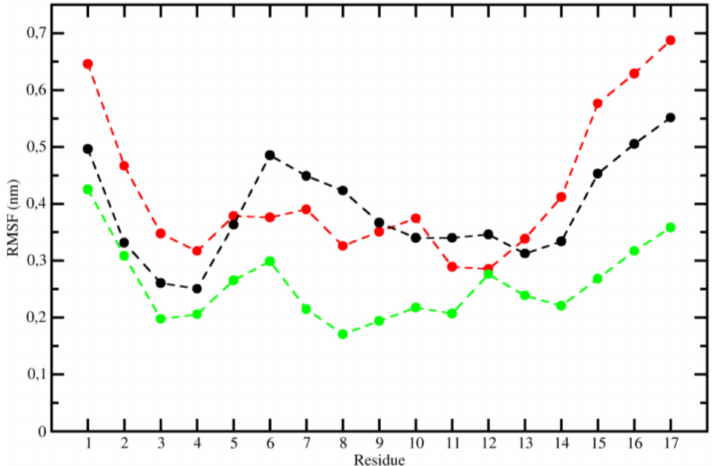
Figure 5. Root mean square of the fluctuation (RMSF) per peptide residues over 100 ns from MD simulations. Stigmurin (black), StigA25 (red), and StigA31